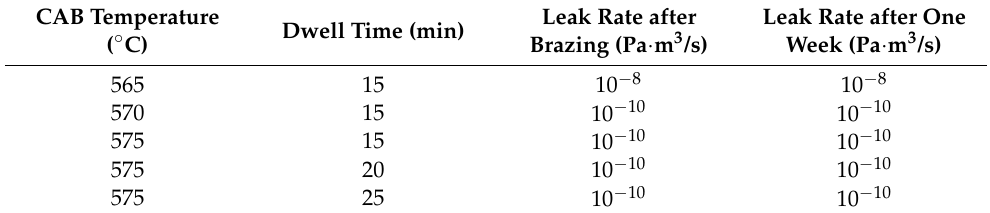
Table 4. Gas tightness of 3003 aluminum joint brazed with melt-spun ribbon at different braz- ing